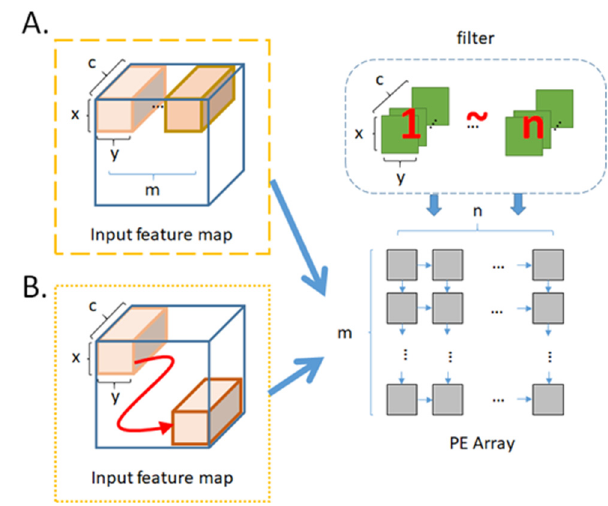
Figure 9. Procedure of filter reuse ( A ) the first iteration ( B ) the successive iterations.